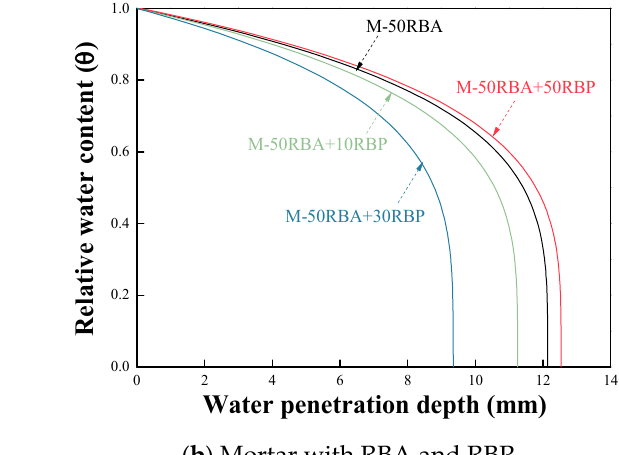
in Figure 13. The results of water distribution in Figure 13 correspond to the results of capillary absorption in Figure 12. The utilized RBP up to 30% decreases the water penetration depth of mortar, while the water penetration of mortar with 50% RBP increases and becomes close to that of the common mortar. For instance, the water penetration depth of M-10RBP, M-30RBP and M-50RBP is 7.4, 17.9 and 1.9% lower than that of M-0RBP, respectively. Although the utilized RBA increases the water penetration depth, while the water penetration depth with 50% RBA and 30% RBP is lower than that without RBA and RBP. For example, the water penetration depth of M-50RBA+10RBP, M-50RBA+30RBP and M-50RBA+50RBP is 7.3% lower, 22.9% lower and 3.3% higher than that of M-50RBA, respectively.